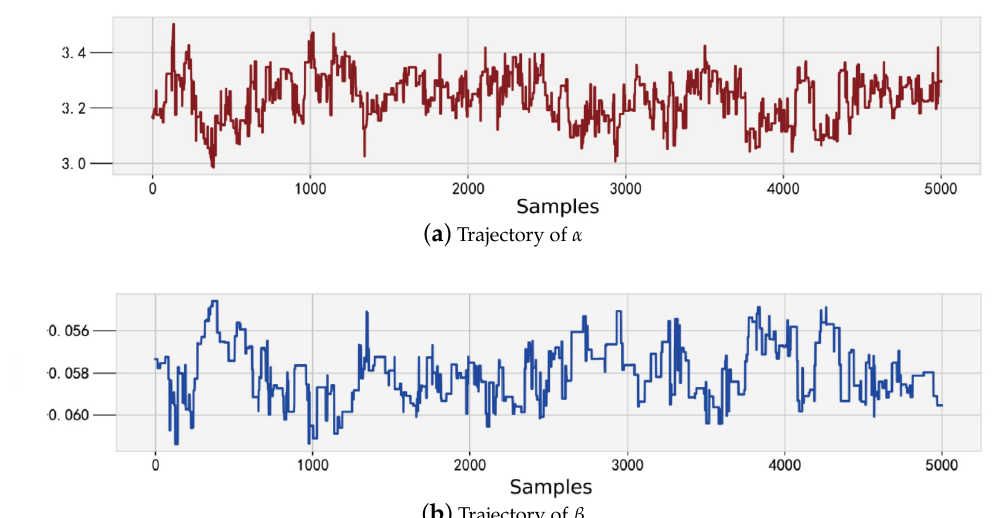
Figure 7. Parametric trajectory of the desktop computer power-on